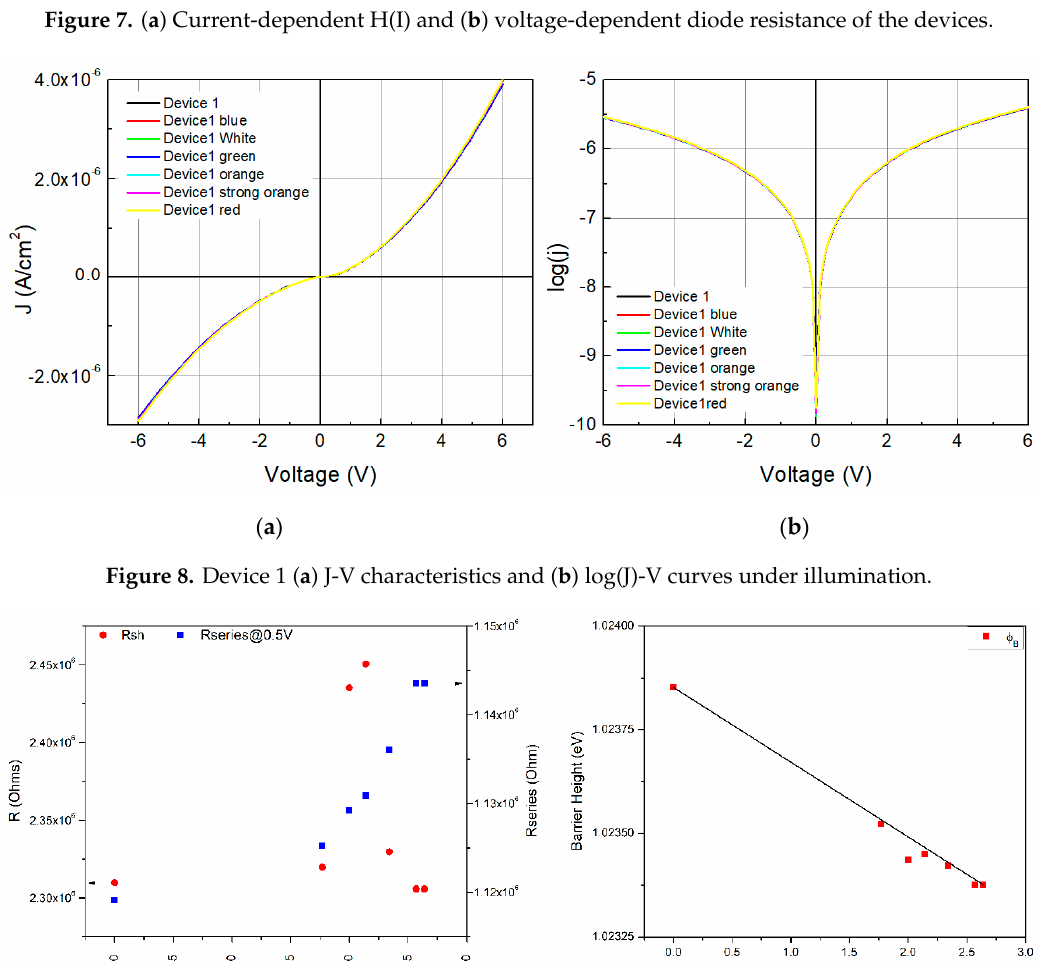
Figure 7. ( a ) Current-dependent H(I) and ( b ) voltage-dependent diode resistance of the devices.